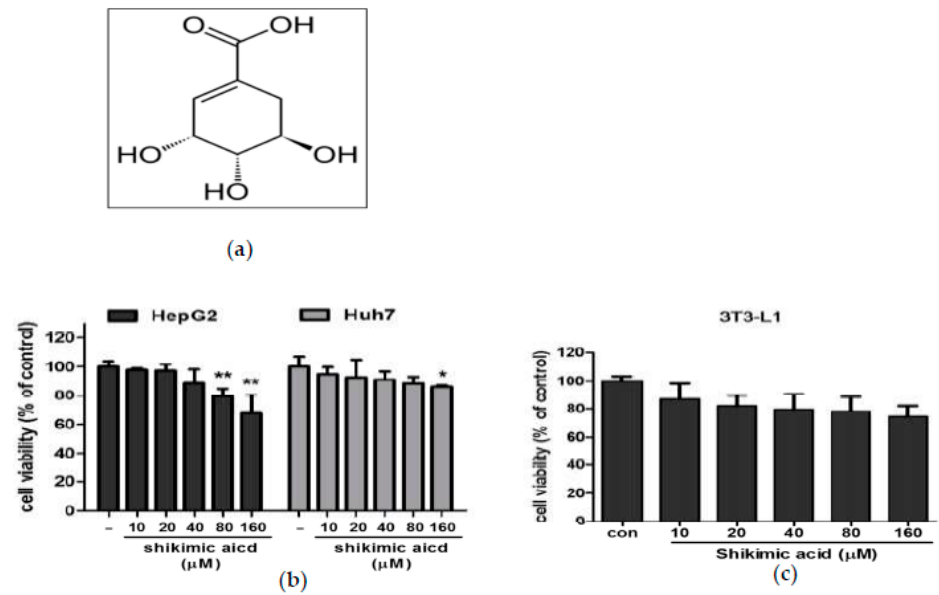
Figure 1. Chemical structure of shikimic acid and its effect on cytotoxicity in HepG2, Huh7 and 3T3 cells. ( a ) Chemical structure of shikimic acid. ( b ) Cytotoxicity of shikimic acid in HepG2 and Huh7 cells. The cells were treated with shikimic acid for 24 h and cytotoxicity was evaluated by 3-(4,5-dimethylthiazol-2-yl)-2,5-diphenyltetrazolium bromide MTT assay ( c ) Cytotoxicity of shikimic acid in 3T3-L1 cells. Results represent means ± S.D. from three independent experiments. * p < 0.05, ** p < 0.01 versus control.